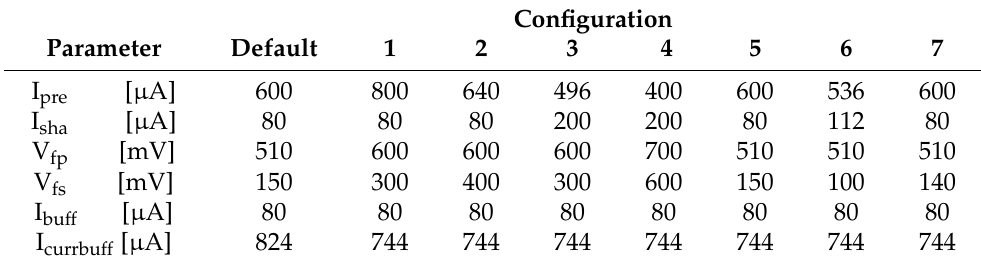
Figure 6. The first set of the pulse shapes with the configurations 1–4 ( left ) and the second set with configurations 5–7 ( right ). Table 1. Overview of the different front-end configuration settings used. The numbers correspond to the curves presented in Figure